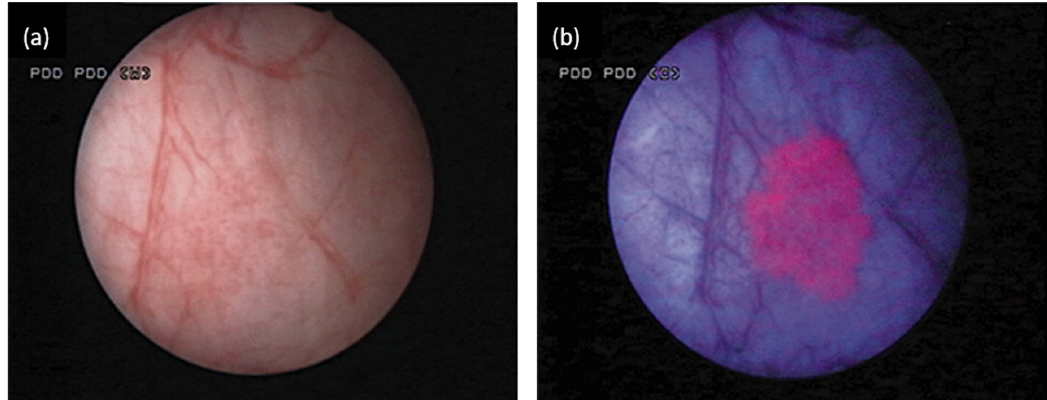
Figure 3. White light ( a ) and blue light fluorescence ( b ) endoscopic image of a flat tumour in situ (Tis). 5-ALA solution was instilled intravesically before cystoscopy. This is revealed by reddish